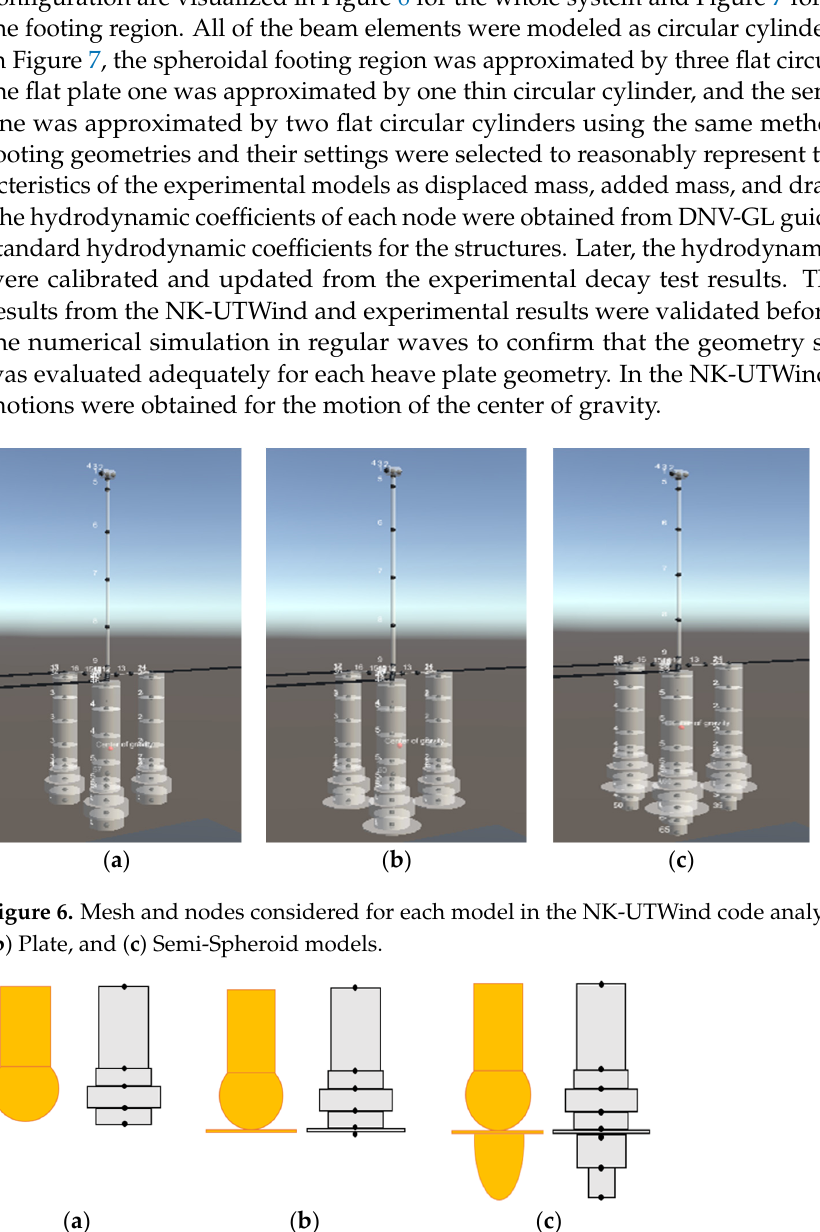
( c ) Figure 8. View of the WAMIT code models with high ‐ order meshes and mooring setup in EDTools ® : ( a ) Sphere, ( b ) Plate, and ( c ) Semi ‐ Spheroid models. Since the viscous effect is not considered in the potential theory calculation, it was incorporated into the external damping matrix. The external damping was estimated firstly from the free decay tests and then incorporated into the numerical model. Different values of viscous damping were considered and compared to observe the sensibility of the response due to this parameter. 4. Results and Discussions Three main results are discussed in this article: first, free decay and hammering tests; second, motion responses; and third, bending strains. Numerical analyses were conducted in full ‐ scale models; all of the results were presented on a reduced scale of 1/50. 4.1. Free Decay and Hammering Tests The results of natural periods and added mass coefficients obtained from free decay tests are shown in Tables 4 and 5, respectively.